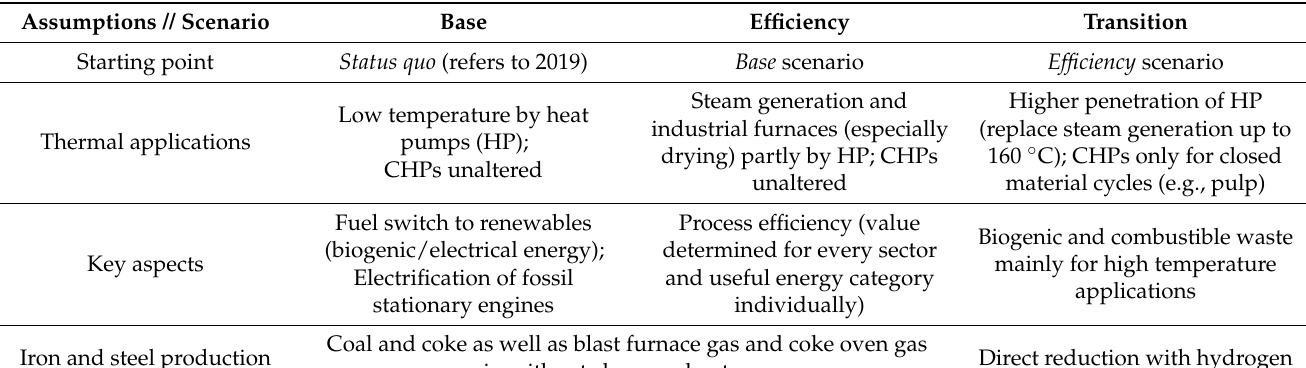
Table 1. Overview of the storylines of the three defined scenarios (detailed assumptions are described in the IndustRiES study